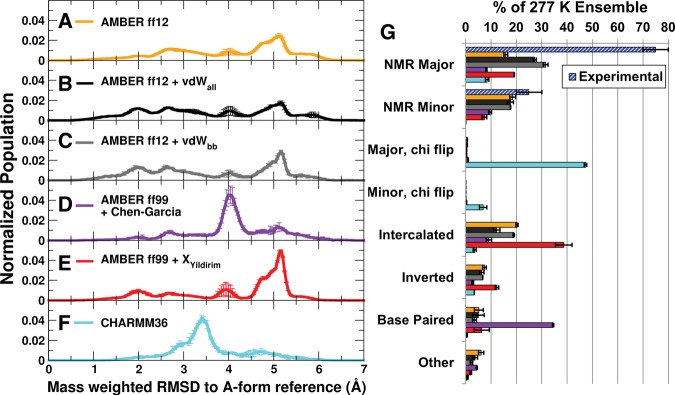
(Left) M-REMD RMSD to A-form Reference for r(GACC). (A) ff12, (B) ff12 + vdWall, (C) ff12 + vdWbb, (D) ff99 + Chen–Garcia, (E) ff99 + χYil, and (F) C36 force fields. The averages between two runs per force field are shown, with error bars shown as the standard deviation. RMSDs corresponding to NMR major and minor structures are ∼2.0 Å and 2.6 Å, respectively. (G) Populations of major conformation types seen in cluster analysis of each M-REMD simulation. Bars indicate the average and standard deviation between two independent runs and are colored by force field to match the RMSD histograms. Experimental values are shown on the table in a blue striped pattern. Representative structures and classifications (including discussion of the conformations classified as “Other”) are shown in Supplemental Table 1 and Supplemental Figure 2.